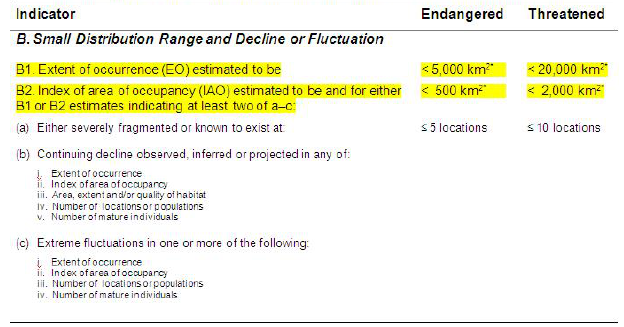
Fig. 2 . Committee on the Status of Endangered Wildlife in Canada (COSEWIC) quantitative assessment criteria: Phase I Section B (COSEWIC 2010 a